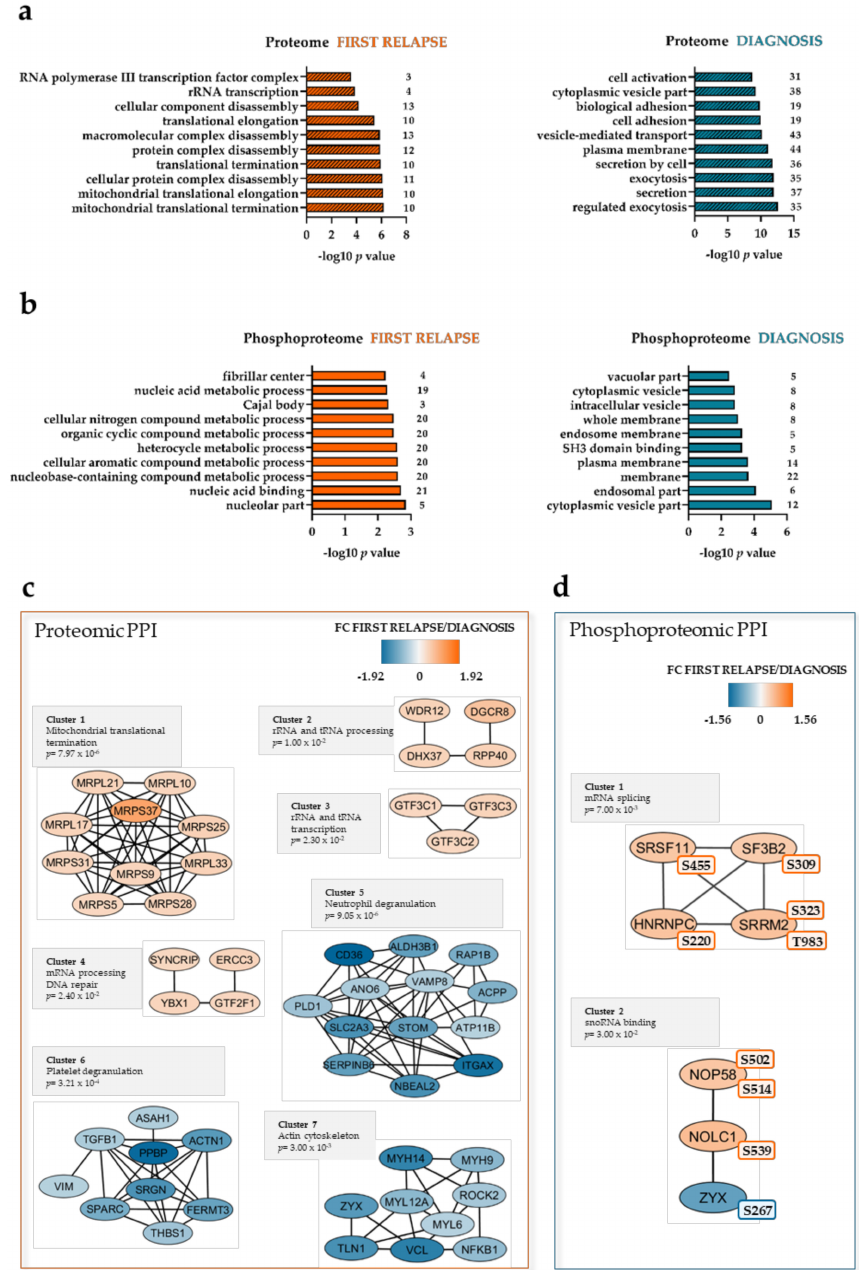
Figure 2. The AML proteome and phosphoproteome are enriched in mitochondrial ribosomal, RNA-processing, and DNA repair proteins at first relapse. Gene ontology (GO) analysis was conducted for the proteome ( a ) and phosphoproteome ( b ), separately. Top 10 enriched GO categories are shown on the y-axis of each bar plot. The -log 10 p values and the number of proteins associated with these GO categories are shown on the X-axis. Dashed bars represent GO categories that are also significantly enriched with false discovery rate (FDR) < 0.05. ( c , d ) Networks of protein–protein interactions (PPI) based on STRING search of the proteomic and phosphoproteomic datasets and visualized in Cytoscape after ClusterONE analysis. Significance of high cohesiveness of protein and phosphoprotein networks is shown by the p value of a one-sided Mann–Whitney U test. Fold changes (FCs) of protein expression or phosphorylation according to the super-SILAC (Stable Isotope Labeling with Amino acids in Cell culture) mix method are color-coded; orange-colored proteins showed a higher expression or phosphorylation in the FIRST RELAPSE group, and Yale blue-colored proteins showed a higher expression or phosphorylation in the DIAGNOSIS group. The di ff erentially regulated phosphorylation site(s) is shown next to each